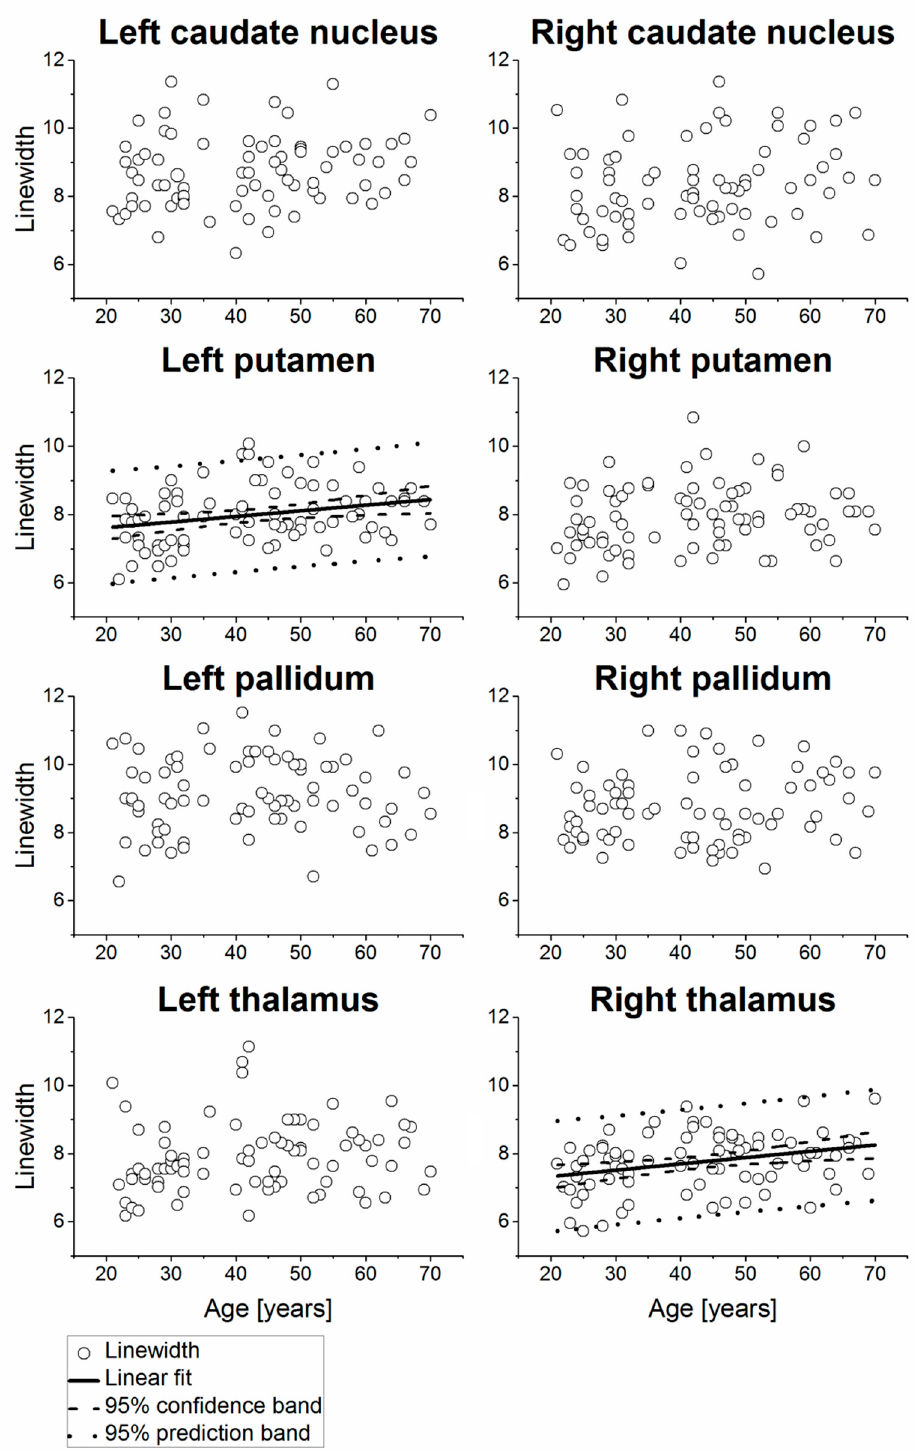
Figure 6. Spectral linewidths of the subjects measured from bilateral caudate nucleus, putamen, pallidum, and thalamus of the subjects, shown as a function of age, including linear fits with 95% prediction interval and 95% confidence interval for statistically significant cases ( p < 0.05). The values are presented in Hz.